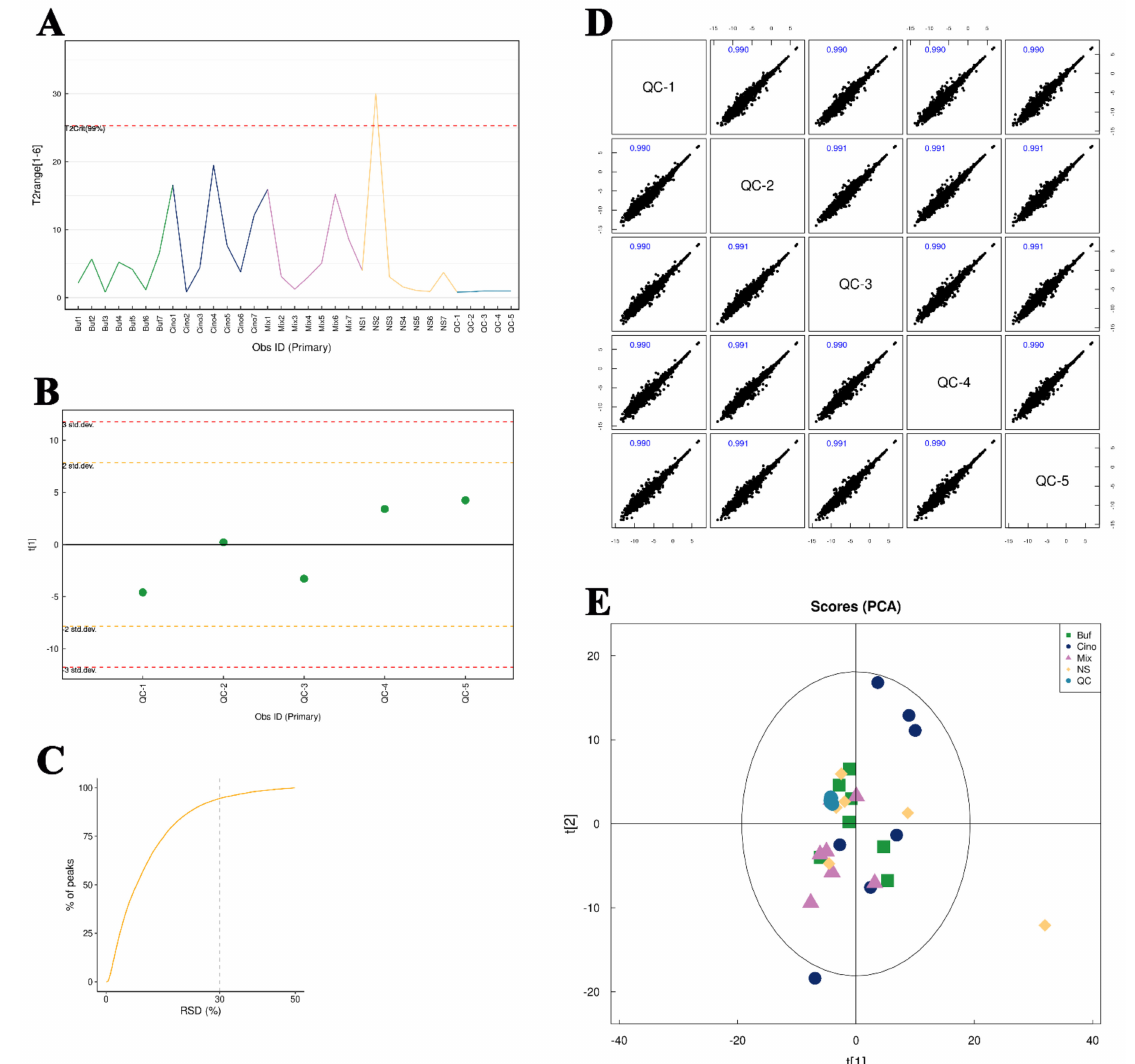
Pg 42:11. Figure 9A displays the correlation analysis of differential metabolites between the Mix and NS groups. Red color indicates a positive correlation, while blue color indi- cates a negative correlation. The higher value represents the closer correlation between two metabolites.